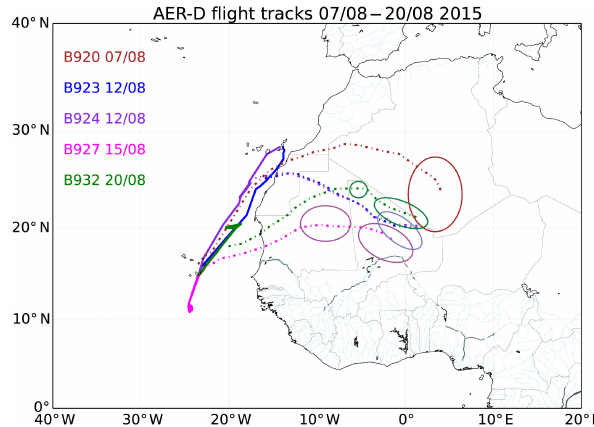
Figure 1. Flight tracks and dust source locations (circles). Dotted lines between flight tracks and circles show the approximate mean trajectory based on SEVIRI RGB dust images as well as NAME and HYSPLIT back trajectories. Note that flights B923 and B924 sampled the same dust